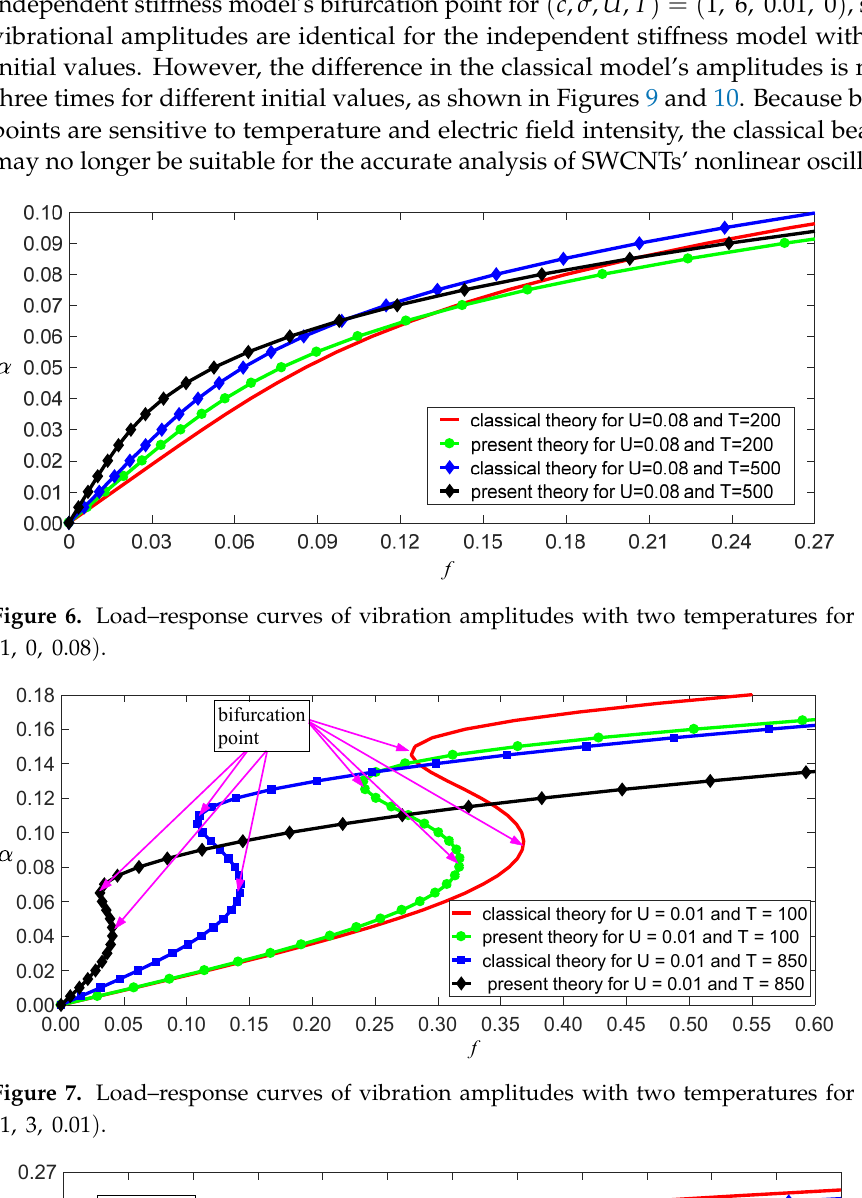
classical theory for U = 0.01 and T = 0 present theory for U = 0.01 and T = 0 classical theory for U = 0.06 and T = 0 present theory for U = 0.06 and T = 0